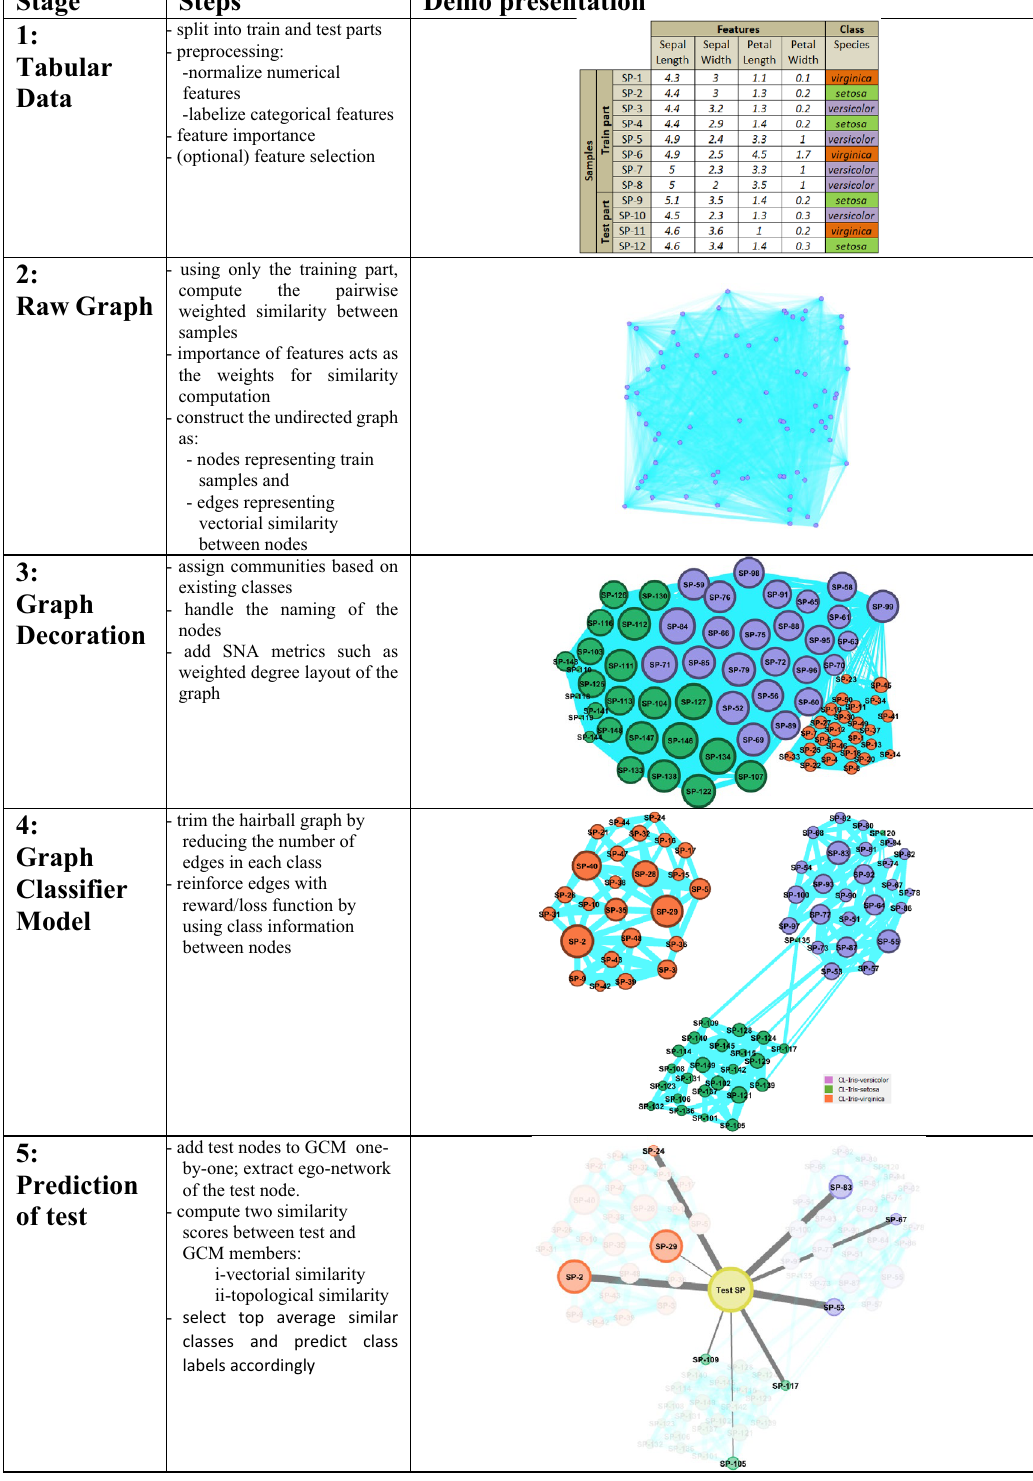
Figure 4. General overview of the GSNAc model illustrated on Iris